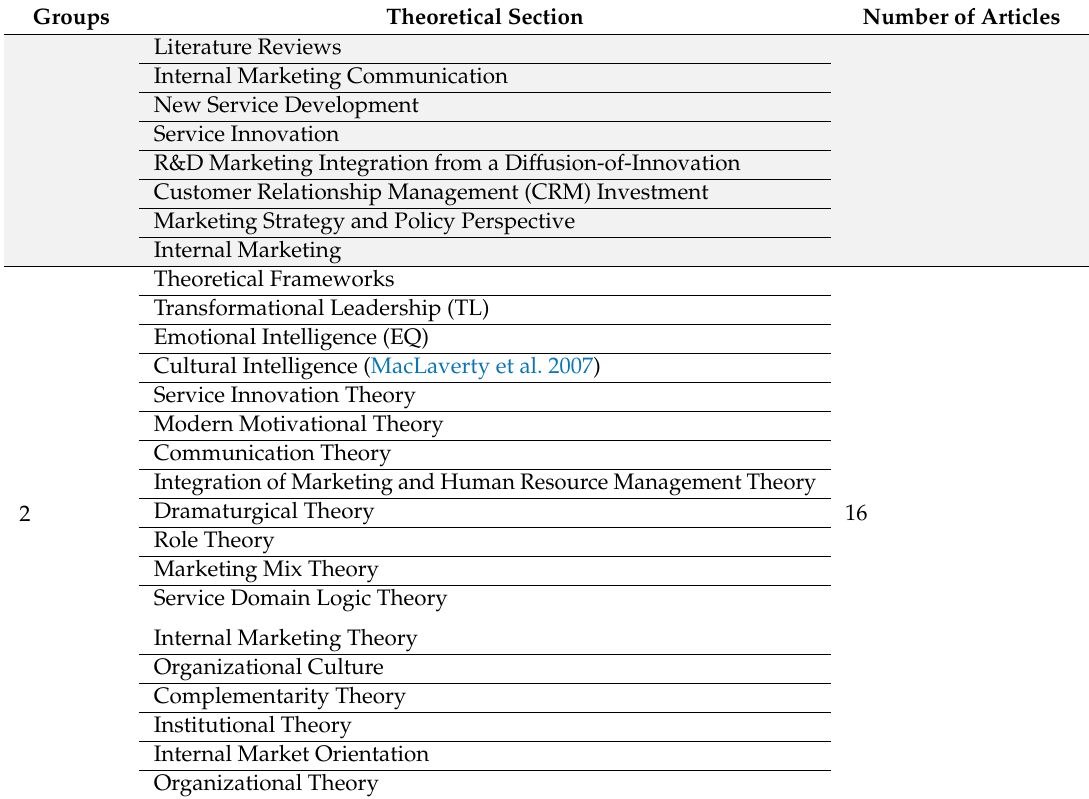
Table 3. Scrutinizing the theoretical sections in the